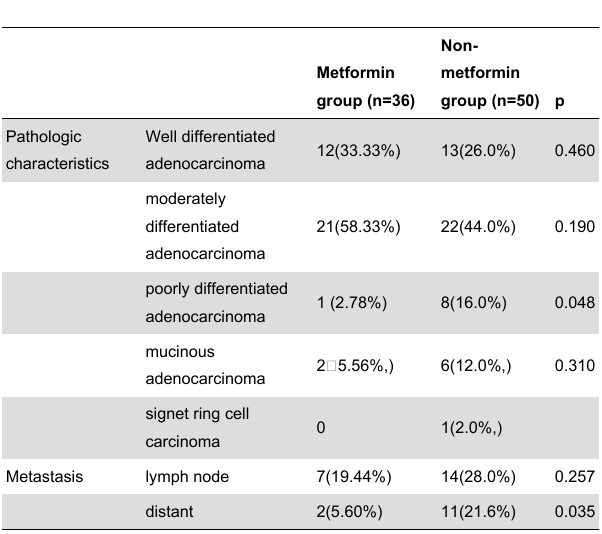
Table 3. The expressions of CD133 and β-catenin in two groups.